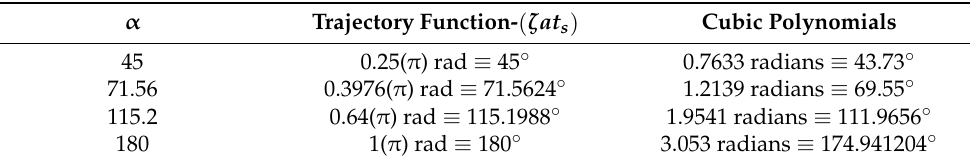
Table 5. Results obtained with the algorithm proposed in this work in comparison with the Cubic Polynomial Algorithm.